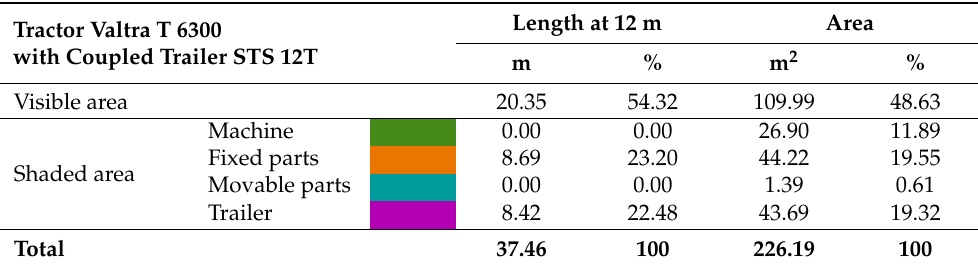
Table 2. Data on length and area characterizing the rear view of the driver of agricultural tractor (trailer in the longitudinal axis of the tractor).